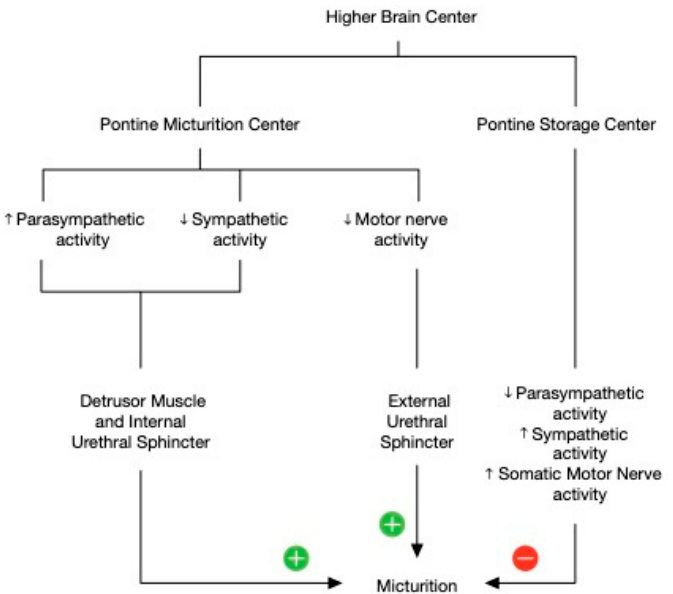
Figure 4. Activity and control involved during micturition.